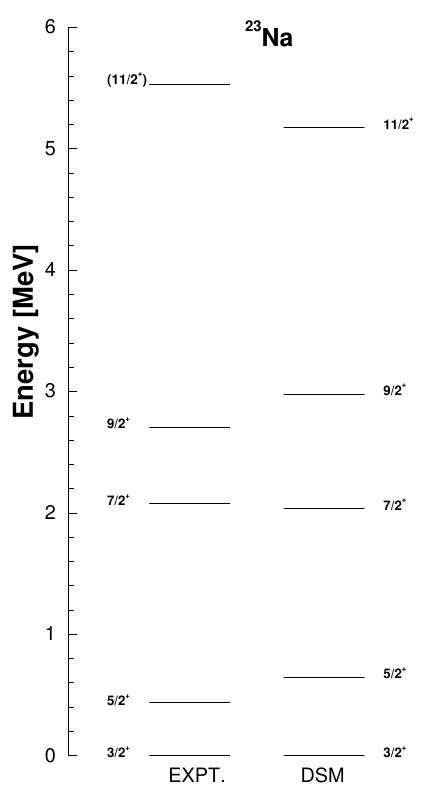
Figure 4. Comparison of deformed shell model results with experimental data for 23 Na for yrast band which is of positive parity. The experimental values are taken from